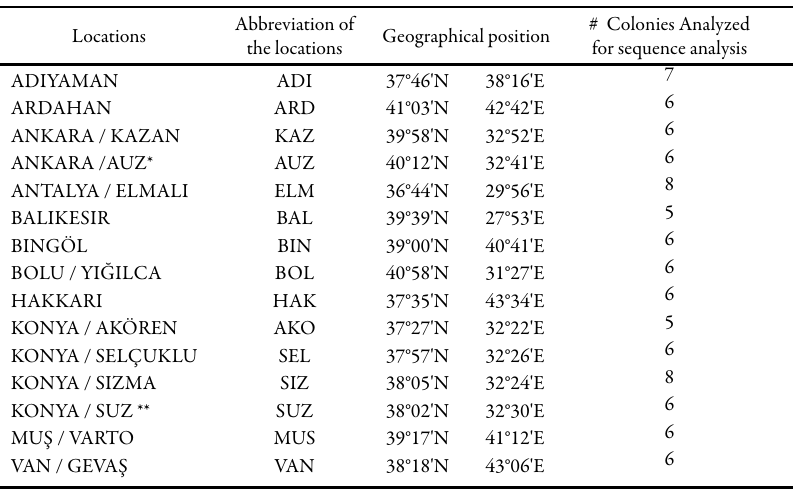
Table 1. Sampling localities, geographical positions and number of colonies used for